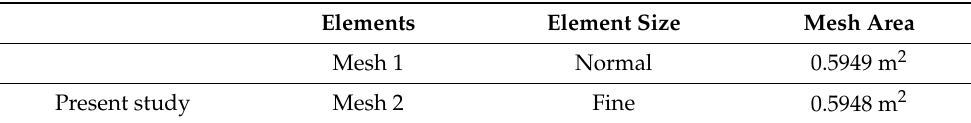
Table 1. The mesh elements computed using